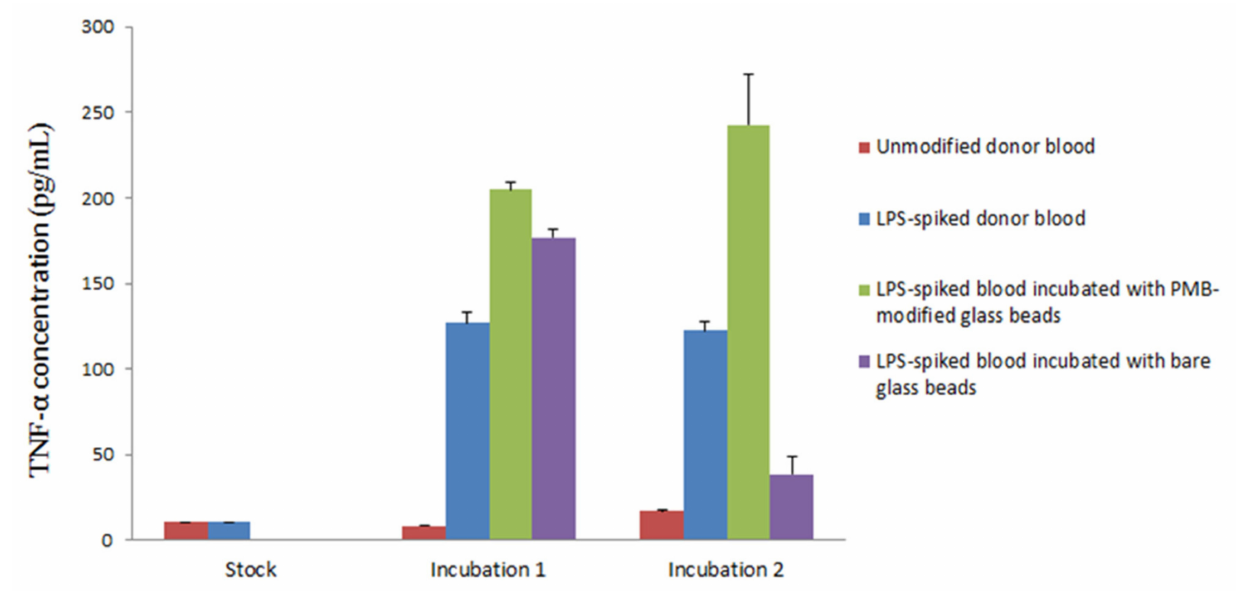
Figure 5. Production of TNF- α cytokine upon two incubations. 1: Incubation of LPS-spiked donor blood with PMB-modified glass beads (green) and bare glass beads (purple). 2: Incubation of plasma samples collected from incubation 1 with naïve blood. Additional unmodified donor blood (red) and LPS-spiked donor blood (blue) were incubated individually as sample controls. (Triplicate analysis. One significant reading for each sample is shown along with standard